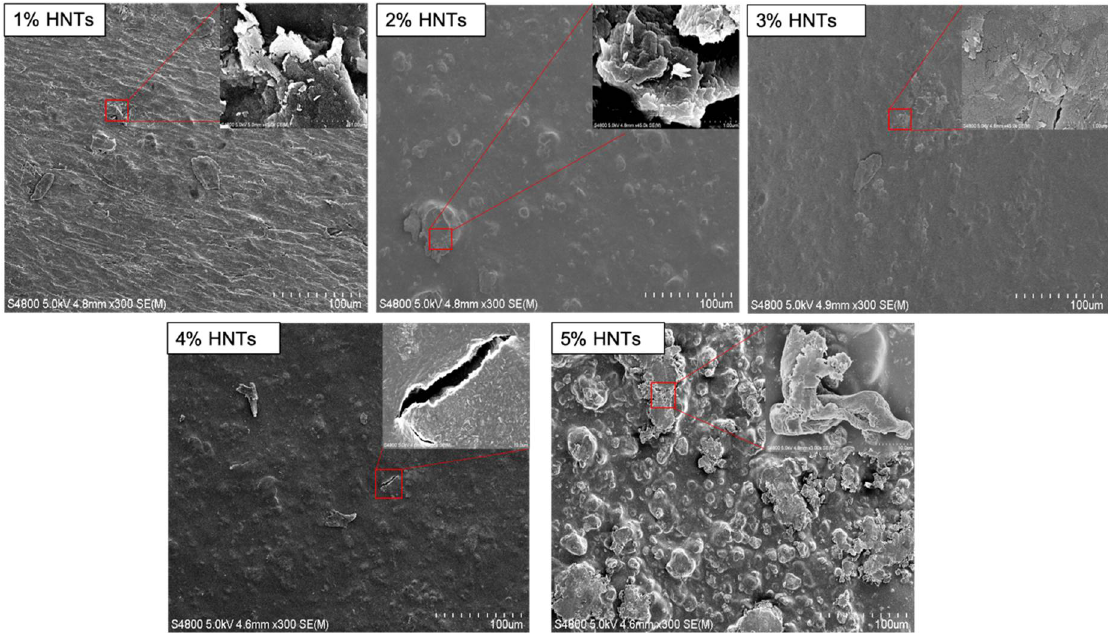
Figure 11. SEM images of hydrogel surface that consisted by 5% chitosan and combined with HNTs at different rations (1% to 5%). The pictures in the right corner are the zoom in pictures of the selected areas.